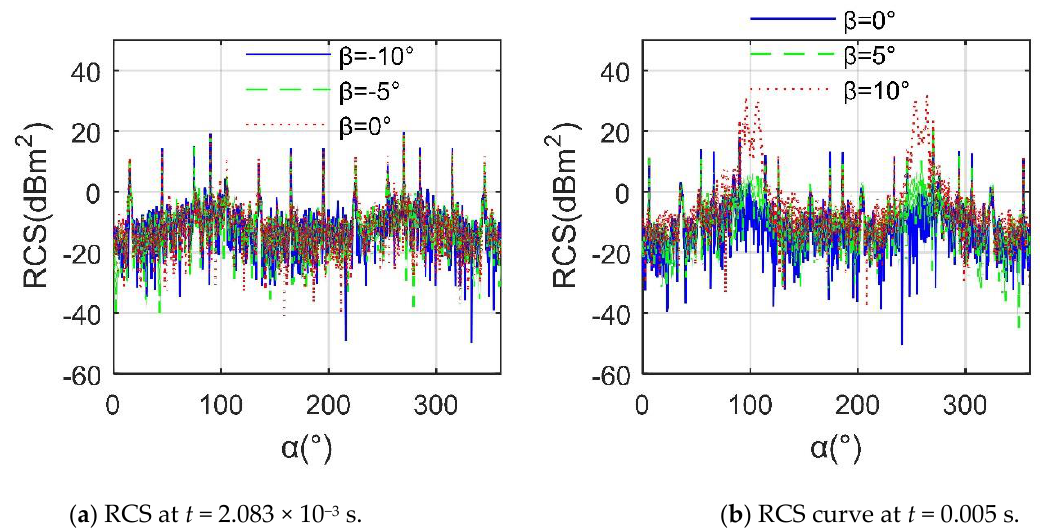
Figure 10. RCS of helicopter at various β , f RH = 10 GHz, n r1 = n r2 = 1200 r/min, A df = A dr = 0°, γ = θ = 0°.